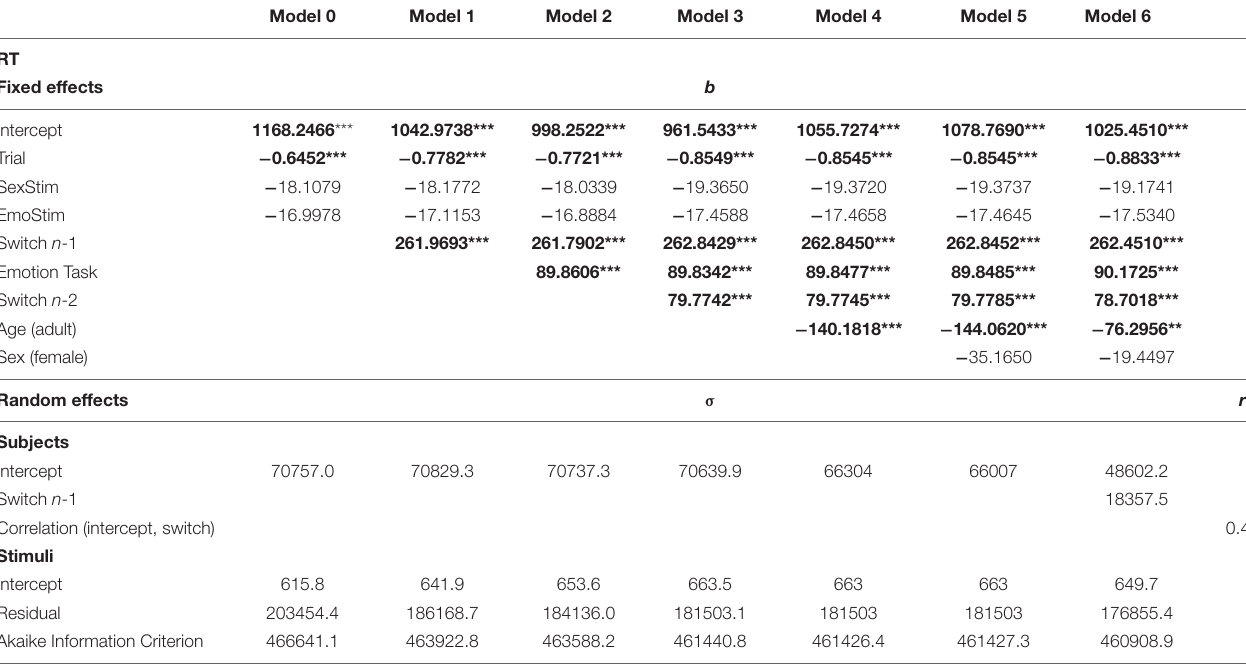
TABLE 3 | Linear Mixed Model results for models 0 to